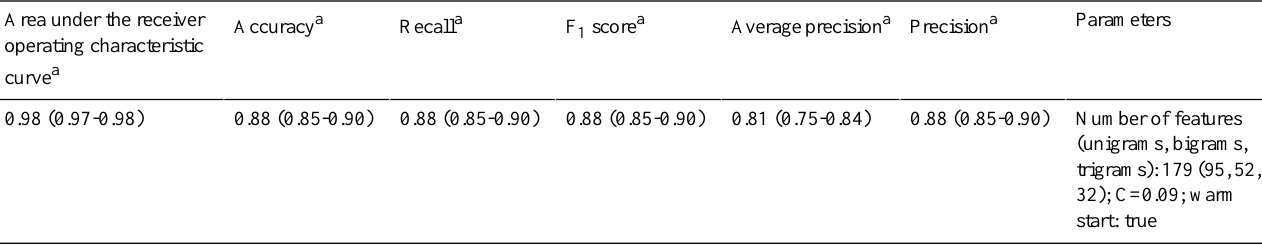
Table 3. Model performance in the hold-out test set and configuration